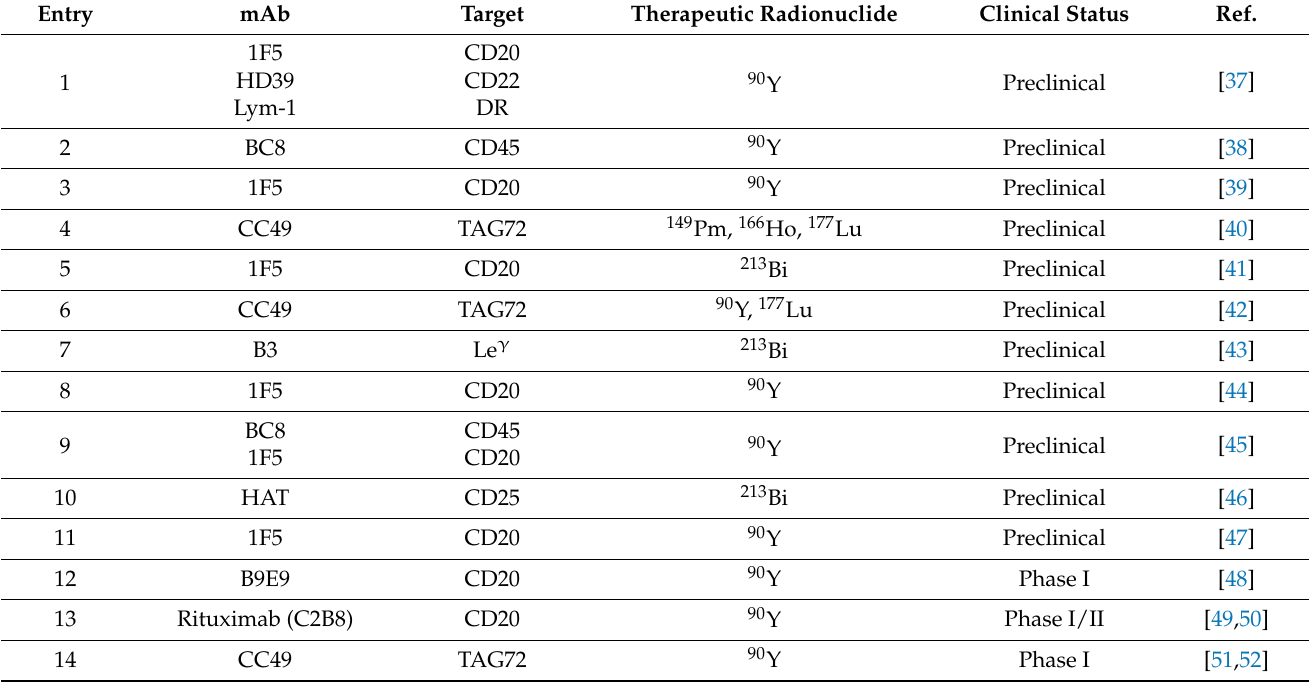
Table 2. Overview of utilized in (pre)clinical studies. In all cases, the CA utilized was